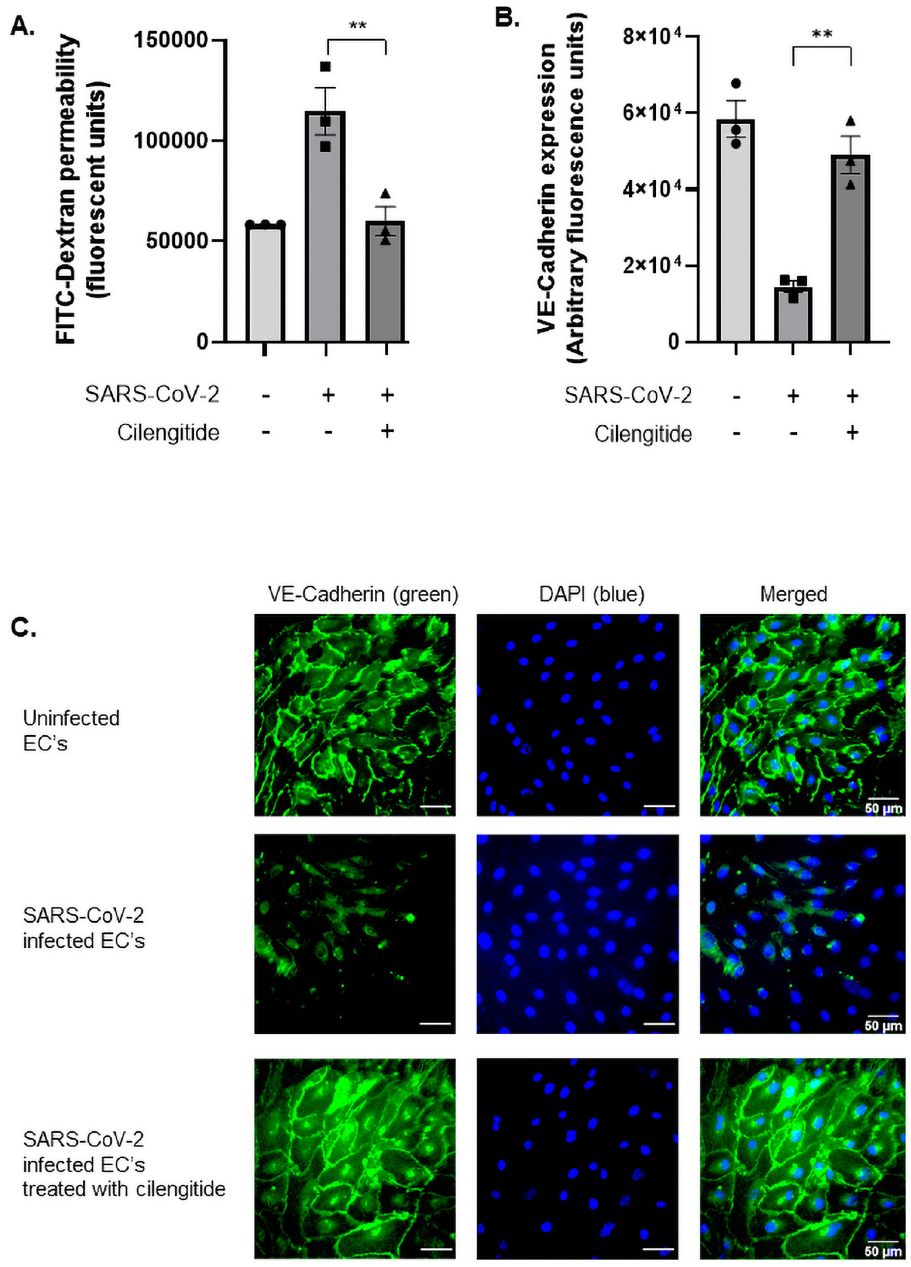
Fig 5. Vascular dysregulation occurs during SARS-CoV-2 infection and can be prevented using an α V β 3 antagonist, Cilengitide. (A) Both treated and untreated endothelial cells were seeded, sheared, and activated in transwell inserts to simulate the physiological conditions of blood flow and stress experienced by the vasculature in- vivo. Following Cilengitide treatment (0.0005 μ M) for one hour, cells were inoculated with SARS-CoV-2 (1.08 x 10 5 TCID50/mL) for 24 hours. Fluorescein isothiocyanate-dextran (FITC-Dextran, 40kDa) was added, which passed through the endothelial cell monolayer into the lower chamber, proportionate to the barrier’s permeability. The extent of permeability was measured by quantifying the fluorescent levels of FITC-Dextran at 490/520 nm. The significant rise in permeability levels indicated severe loss of barrier integrity following SARS-CoV-2 infection, but was restored after treating cells with Cilengitide (P = 0.005; ANOVA f-value = 16.27, N = 3). (B) VE-cadherin levels in uninfected, infected, and treated cells were assessed as a marker of barrier integrity and quantified based on mean fluorescence. The vasculature experienced severe vessel leakage following viral infection, due to significantly reduced expression of VE-Cadherin. When treated with Cilengitide for one hour, barrier permeability was restored back to uninfected levels (P = 0.02; ANOVA f-value = 32.63, N = 3). (C) Vascular-endothelial cadherin (VE-Cadherin) expression on sheared,